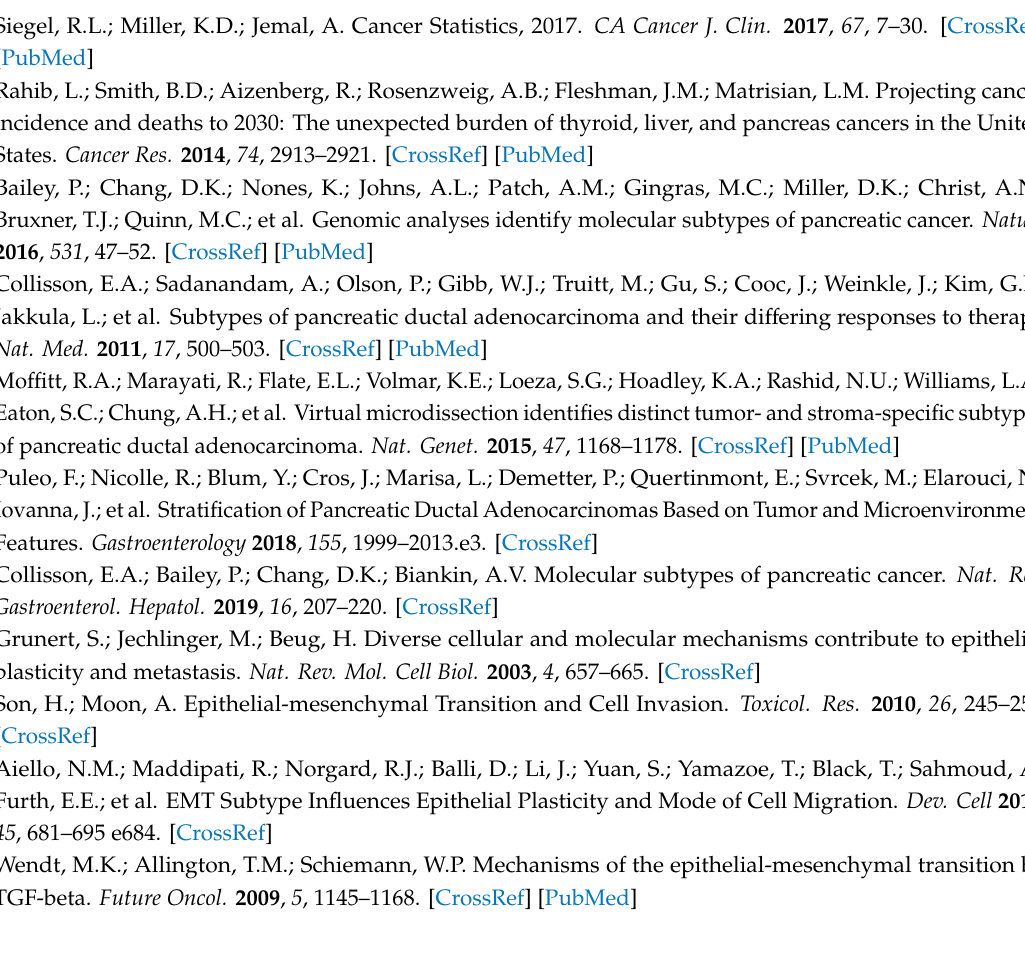
Figure S1: Scatter plots of LINC00261 gene expression and genes important for endodermal cell-fate determination and downregulated in the squamous subtype of the Bailey dataset ( a ). Genes reported to be upregulated in the squamous subtype ( b ). Pearson correlation analysis was performed to determine statistical significance. PDX1, Pancreatic And Duodenal Homeobox 1; GATA6, GATA Binding Protein 6; MNX1, Motor Neuron And Pancreas Homeobox 1; EGFR, Epidermal Growth Factor Receptor; LOX, Lysyl Oxidase; YAP1, Yes-Associated Protein 1. Figure S2: Analysis of the Bailey PDAC dataset revealed a significant downregulation of FOXA2 expression in the squamous (S) compared to the pancreatic progenitor (P), immunogenic (I), and ADEX (A) subtypes (**** p < 0.0001; one-way ANOVA). Figure S3: FOXA2 expression in TGF β -responsive and non-responsive cells using qRT-PCR (* p < 0.05, ** p < 0.01, *** p < 0.001; unpaired t-test). Figure S4: ChIP followed by qPCR analysis showed reduced binding of FOXA2 to the LINC00261 promoter in all 3 experiments performed; however, the di ff erence did not reach statistical significance (* p < 0.05, *** p < 0.001; unpaired t-test). Figure S5: Uncropped blots with molecular weight markers and densitometry readings for Figure 3c, Figure 4d, Figure 4e, and Figure 6b. Table S1: Di ff erentially expressed genes in squamous vs. other subtypes associated with overall survival. Table S2: Patient characteristics (FFPE samples). Table S3: Sequences of PCR primers, cloning oligonucleotides, siRNAs, and sgRNAs. Table S4: Di ff erential gene expression between pLenti empty and LINC00261 i1 / i2. Table S5: Di ff erential gene expression between WT and LINC00261 promoter KO